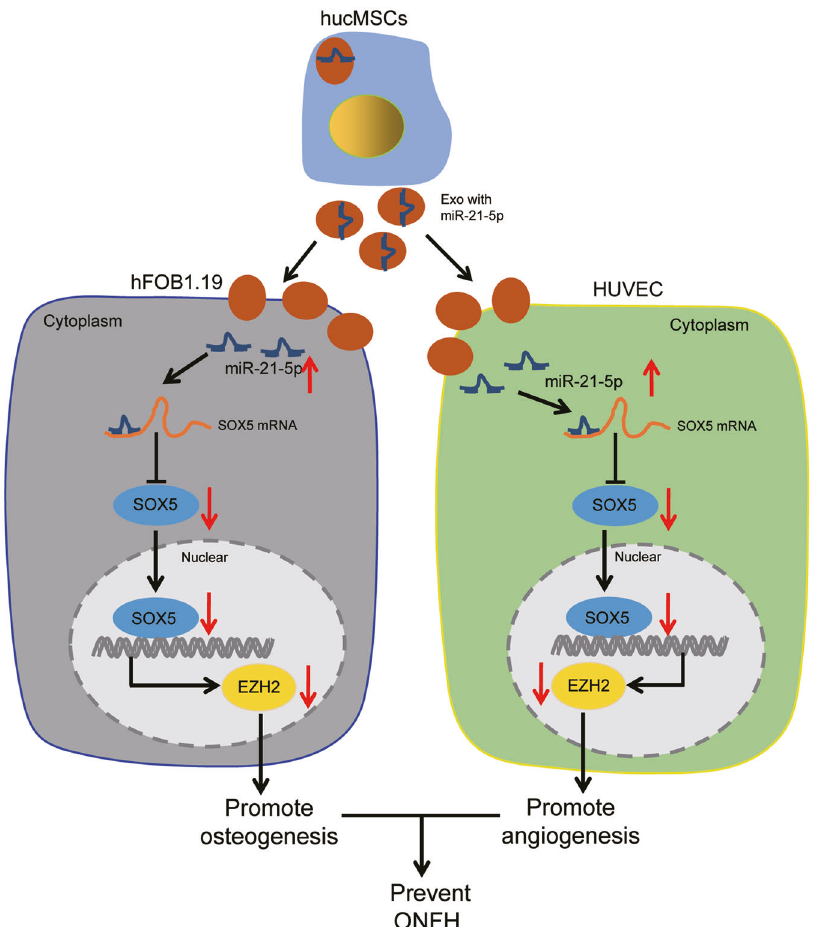
Fig. 6 The mechanism graph of the regulatory network and function of hucMSC-Exos containing miR-21-5p on ONFH. hucMSC-Exos containing miR-21-5p augment HUVEC angiogenesis and hFOB1.19 cell osteogenesis by inhibiting the expression of SOX5/EZH2, thereby preventing